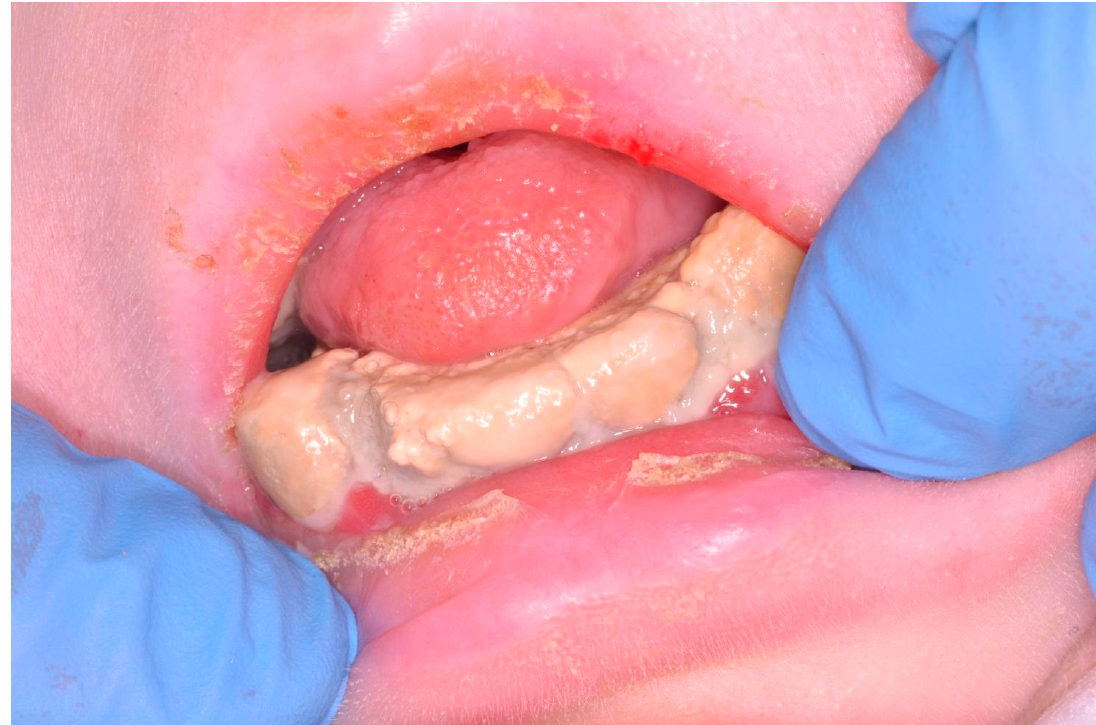
Figure 3. Calculus accumulation and periodontitis in a patient with special needs.